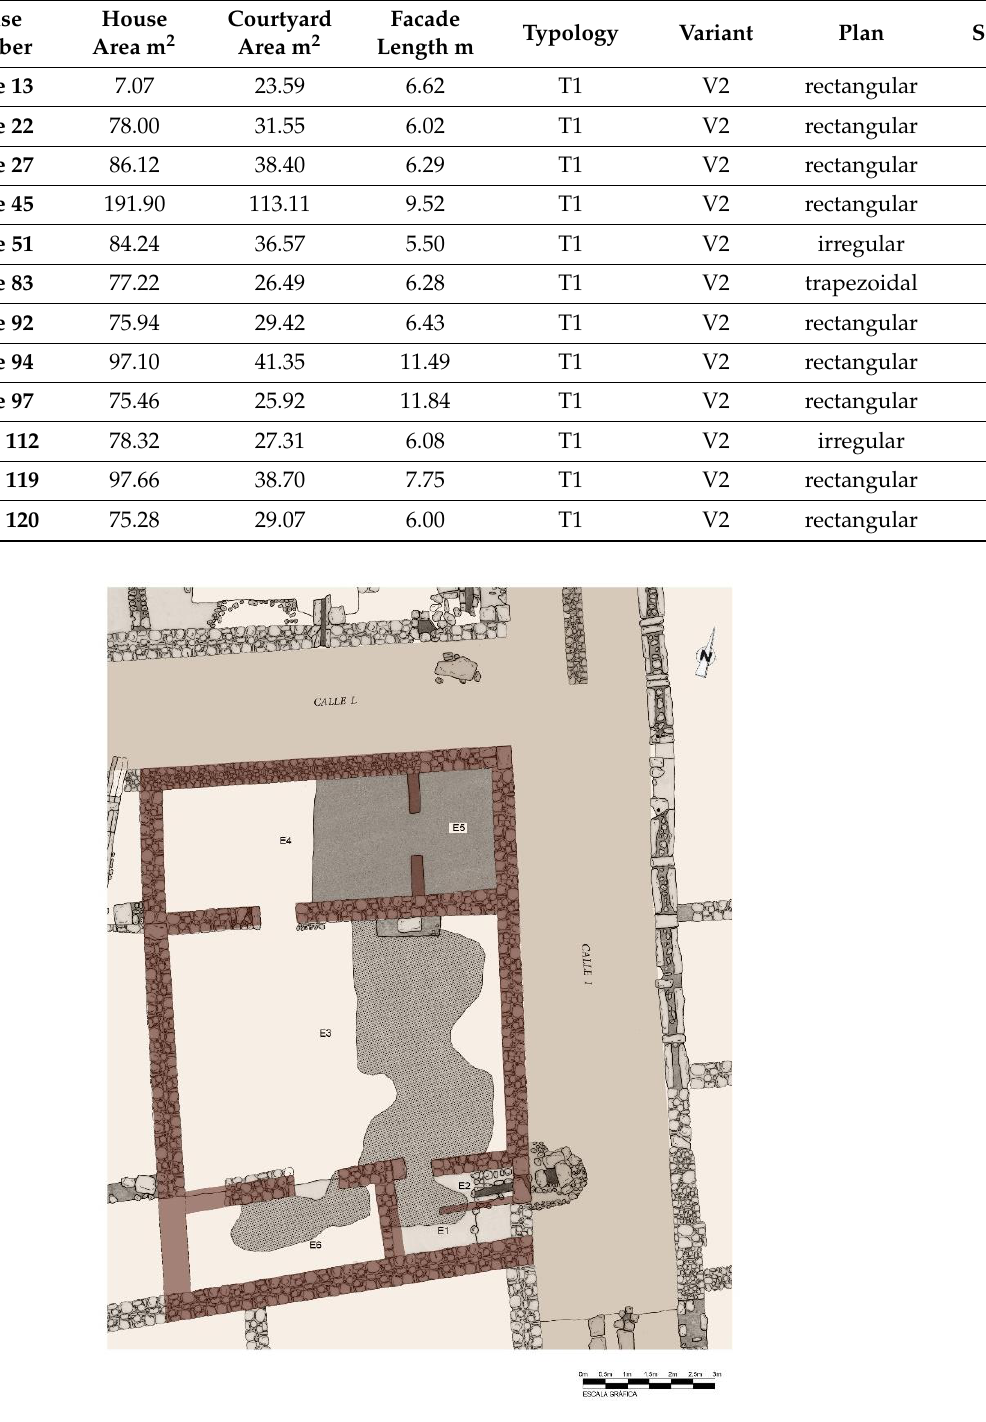
Figure 17. Variant 2. House 94. Plan and room distribution.